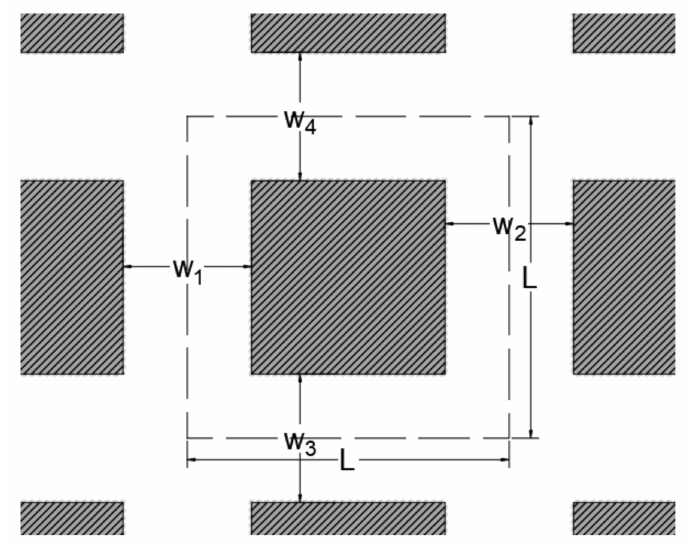
Figure 5. Diagram for land area